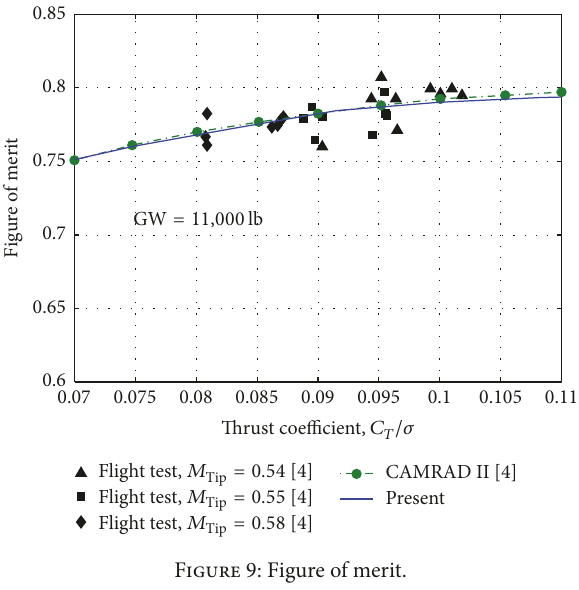
Figure 9: Figure of merit.